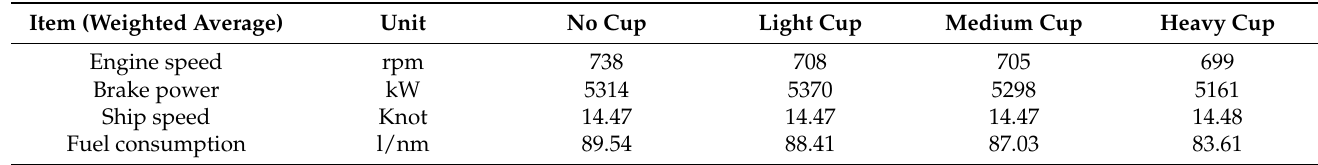
Table 4. Comparison between the weighted average results of the simulated